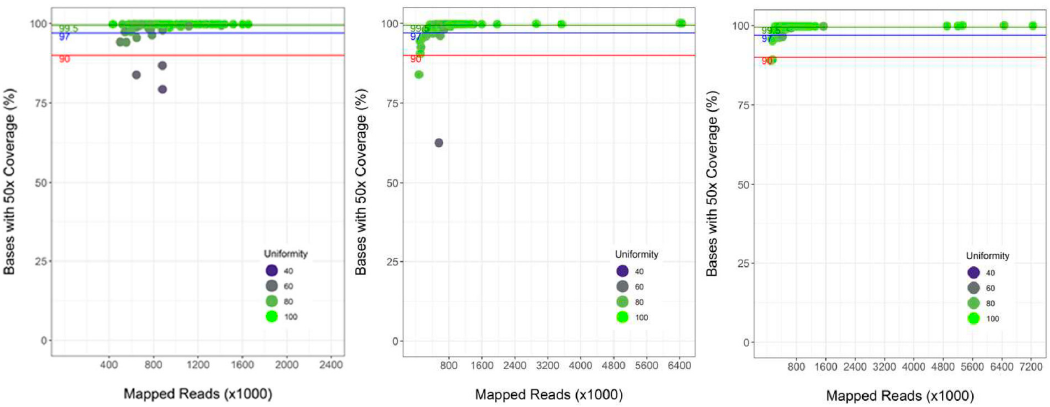
Figure 2. Quality of three high throughput sequencing runs (96 samples per run) from dried blood spots (Ion S5 Prime). Libraries were prepared using the semi ‐ automated AmpliSeq library preparation process.